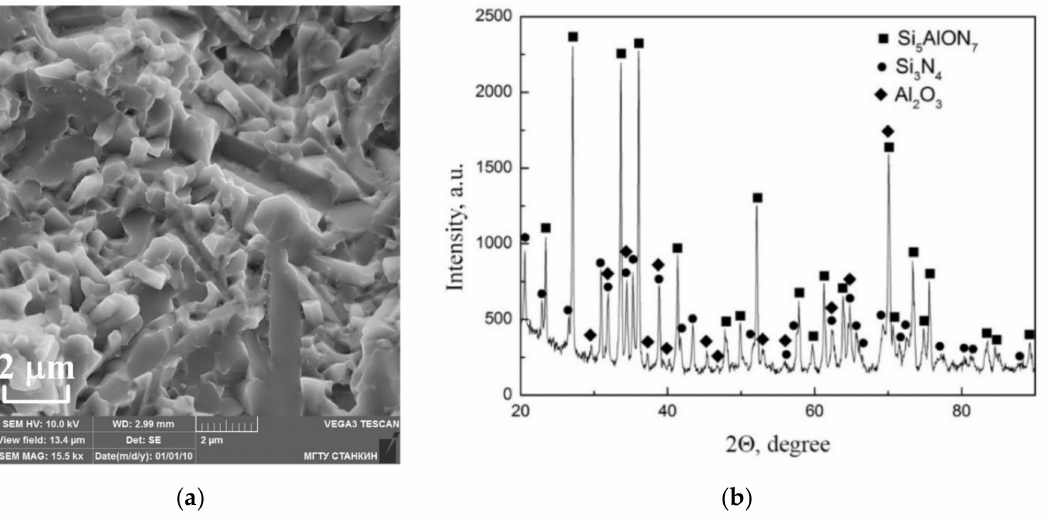
Figure 3. SEM image of the fracture structure of an AS500 ceramic sample ( a ) and the results of its X-ray diffraction (XRD) analysis ( b